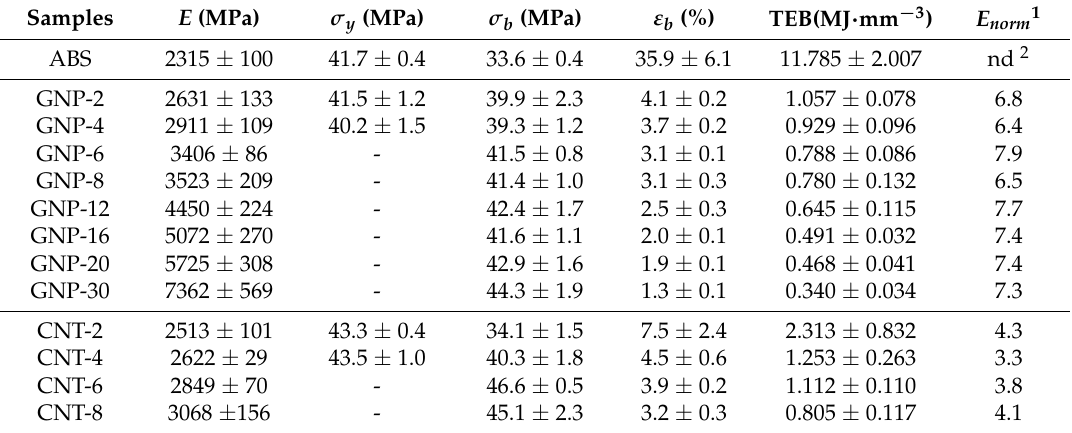
Table 2. Comparison of the tensile properties of ABS/CNT and ABS/GNP nanocomposites.